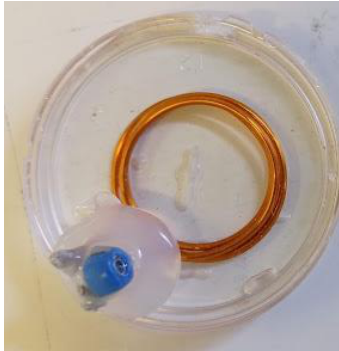
Figure 4. Circular repeater coil.